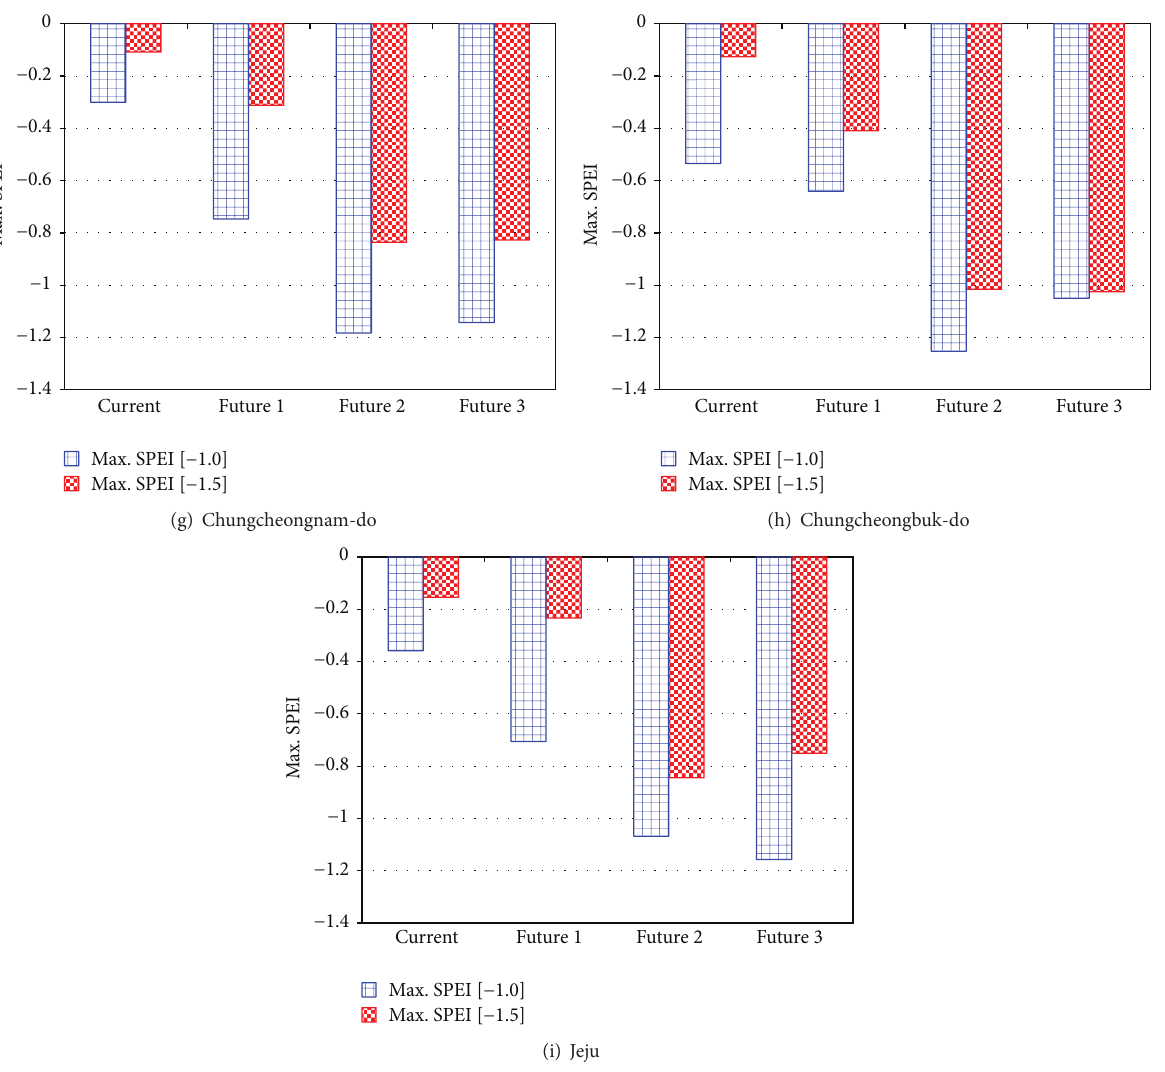
Figure 11: Change in maximum drought intensity in the current and future